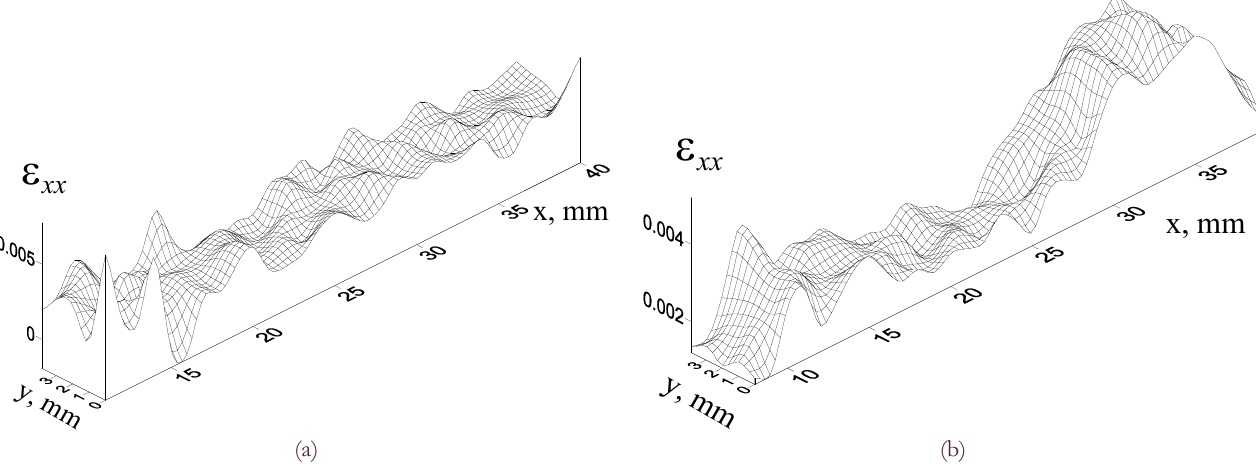
Figure 5: Three-dimensional image of ε xx at the beginning (a) and end (b) of the pre-fracture stage for steel (G10080). Fracture time Fracture coordinate Material